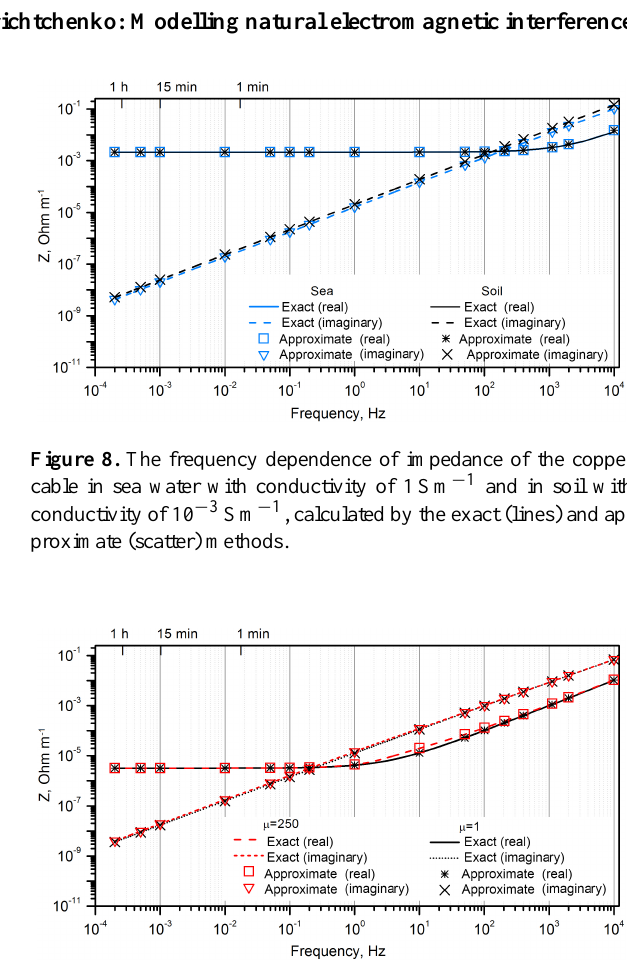
Figure 9. The frequency dependence of impedance of the steel in pipeline with relative permeabilities of 1 and 250 and external me- dia with conductivity 10 − 3 Sm − 1 calculated by the exact (lines) and approximate (scatter) methods.